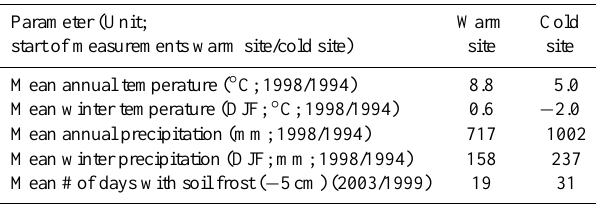
Table 1. Climate characteristics of the two experimental sites, mea- sured on site by the Department of Micrometeorology until 2008; University of Bayreuth, T. Foken (Schuerings et al., 2014). Parameter